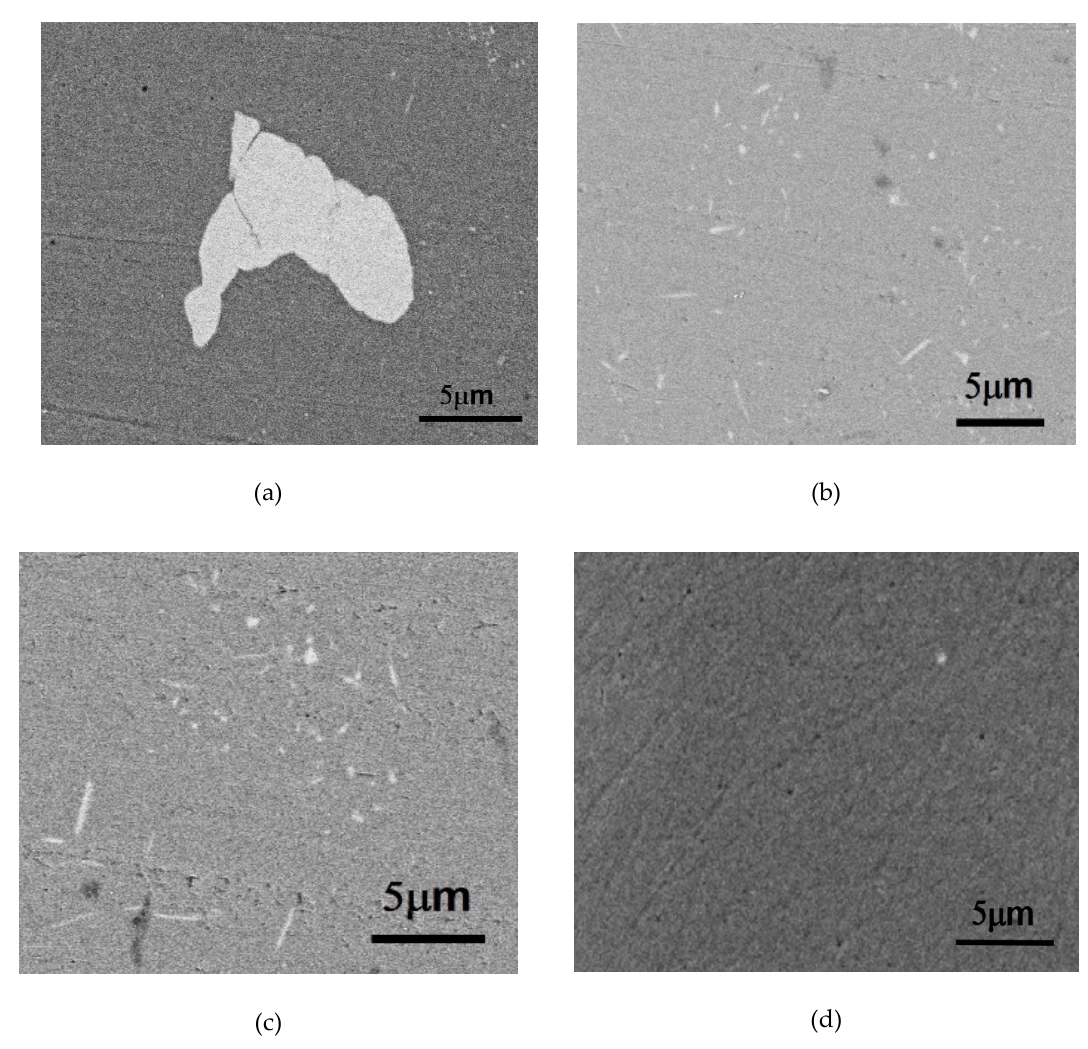
Figure 2. SEM-BEI (Backscattering Electron Image of Scanning Electron Microscope) observation of the Al 6 Mn dispersoids after ( a ) as-cast alloy B (0.8Mn), Al 6 Mn EDS analysis: Al: 70.0 wt.% Mn: 30.4 wt% Mg: 1.1 wt%; ( b ) 1-Homo Alloy B (0.8Mn); ( c ) 2-Homo Alloy B (0.8Mn); ( d ) as-cast Alloy A (0Mn).